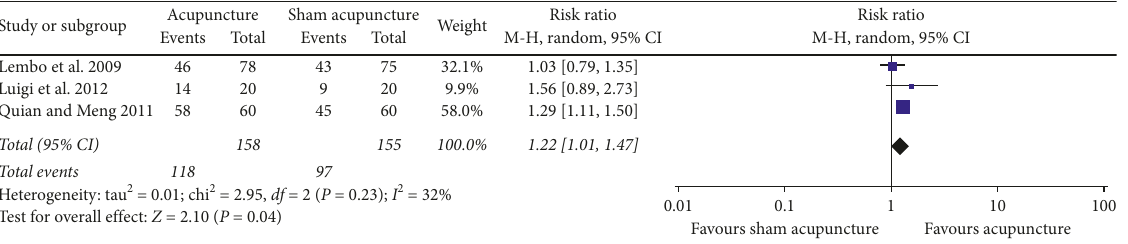
Figure 2: Forest plot for efficacy rates of acupuncture versus sham acupuncture at the end of